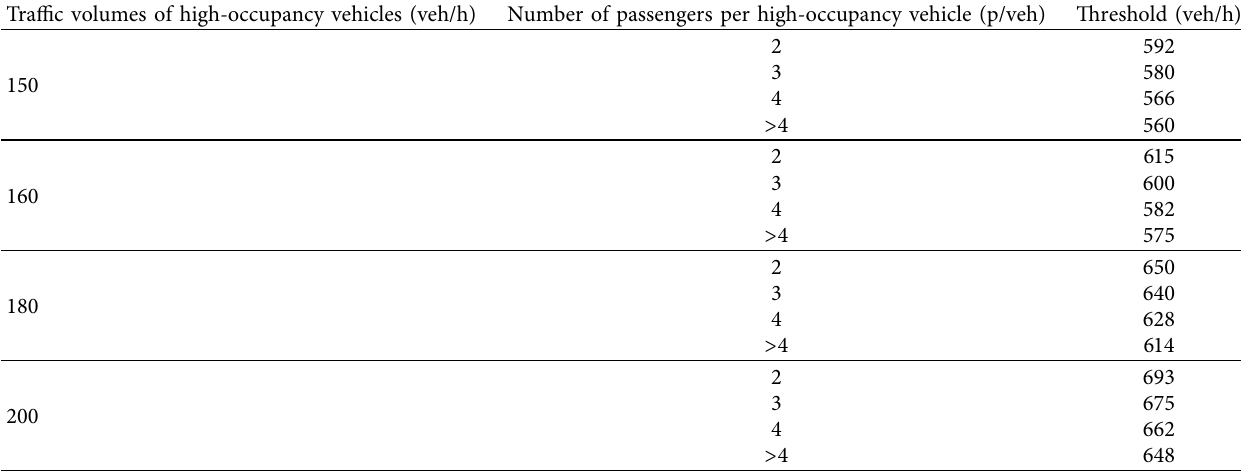
Table 2: Thresholds for different traffic volumes of high-occupancy